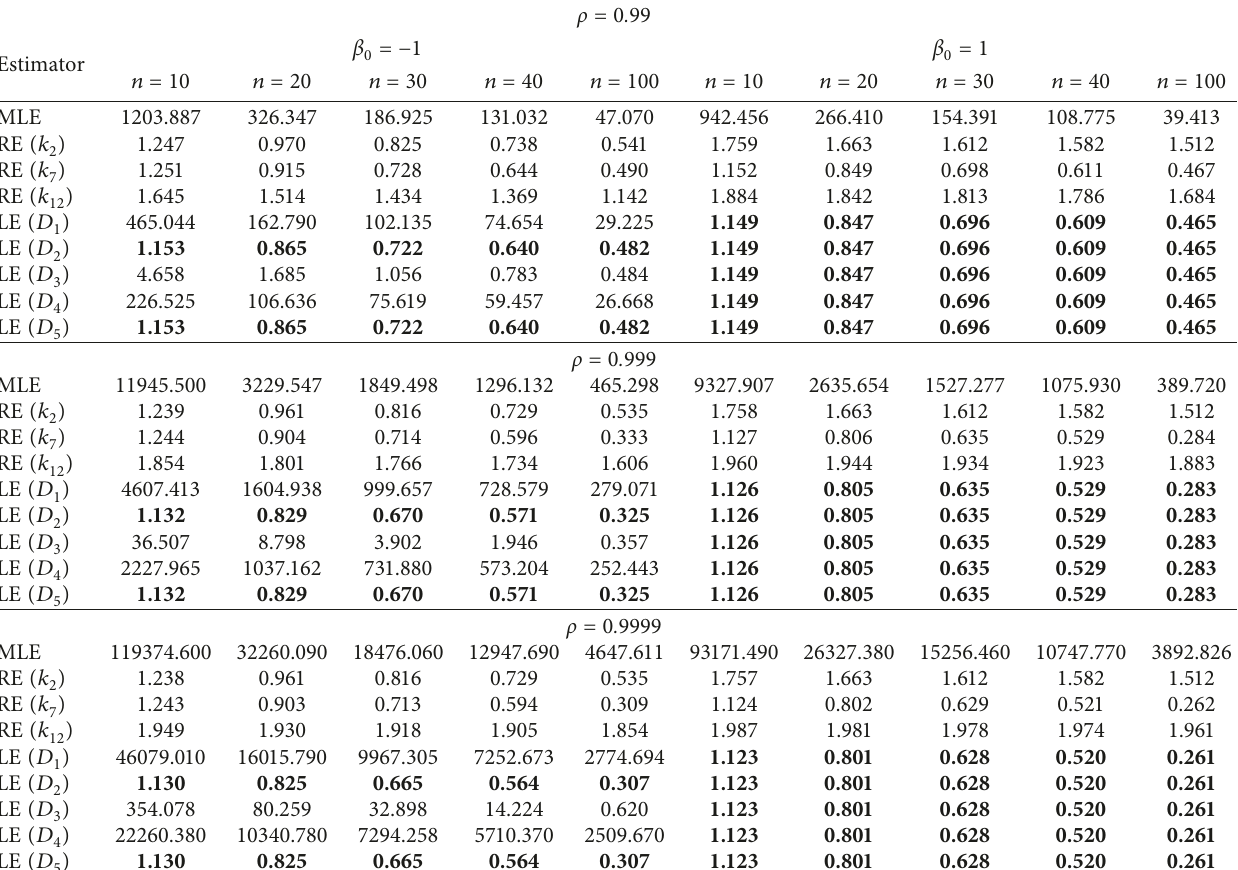
Table 10: Estimated SMSE values for different n, ρ ,k, d, and β